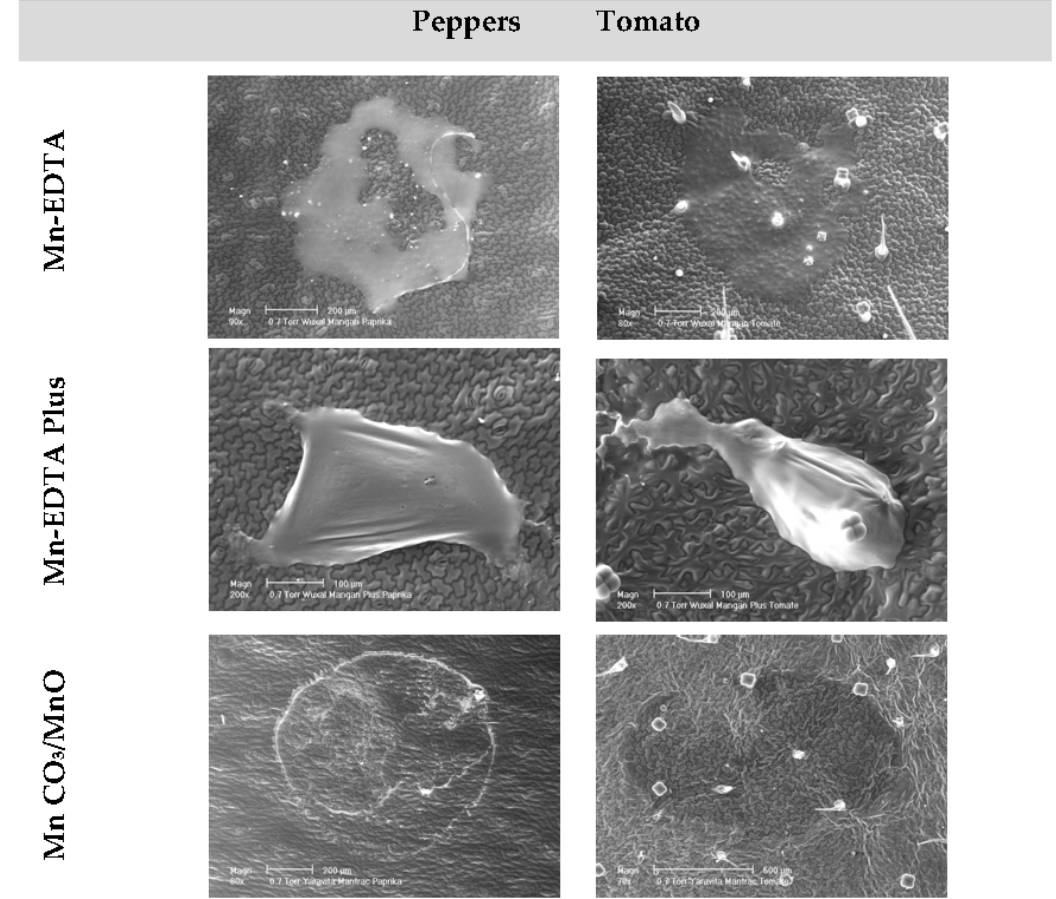
Figure 5. Representative micrographs taken with a scanning electron microscope (please note the scale of each figure). This picture table comprises the formulated manganese-based compounds used.